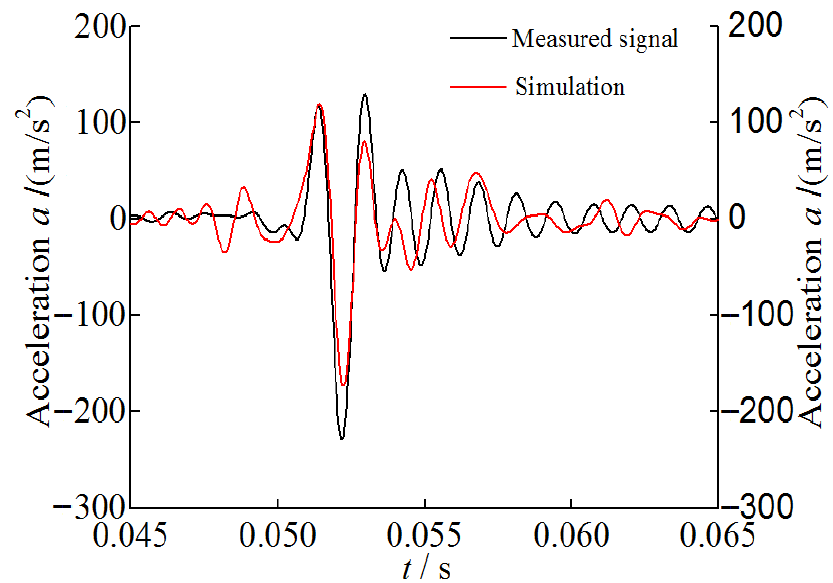
Figure 5. Comparison of acceleration between measurement and simulation.